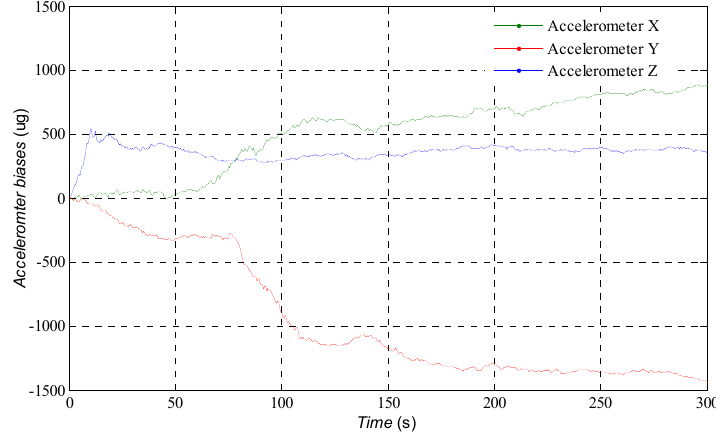
Figure 6. Estimation of the accelerometer bias.